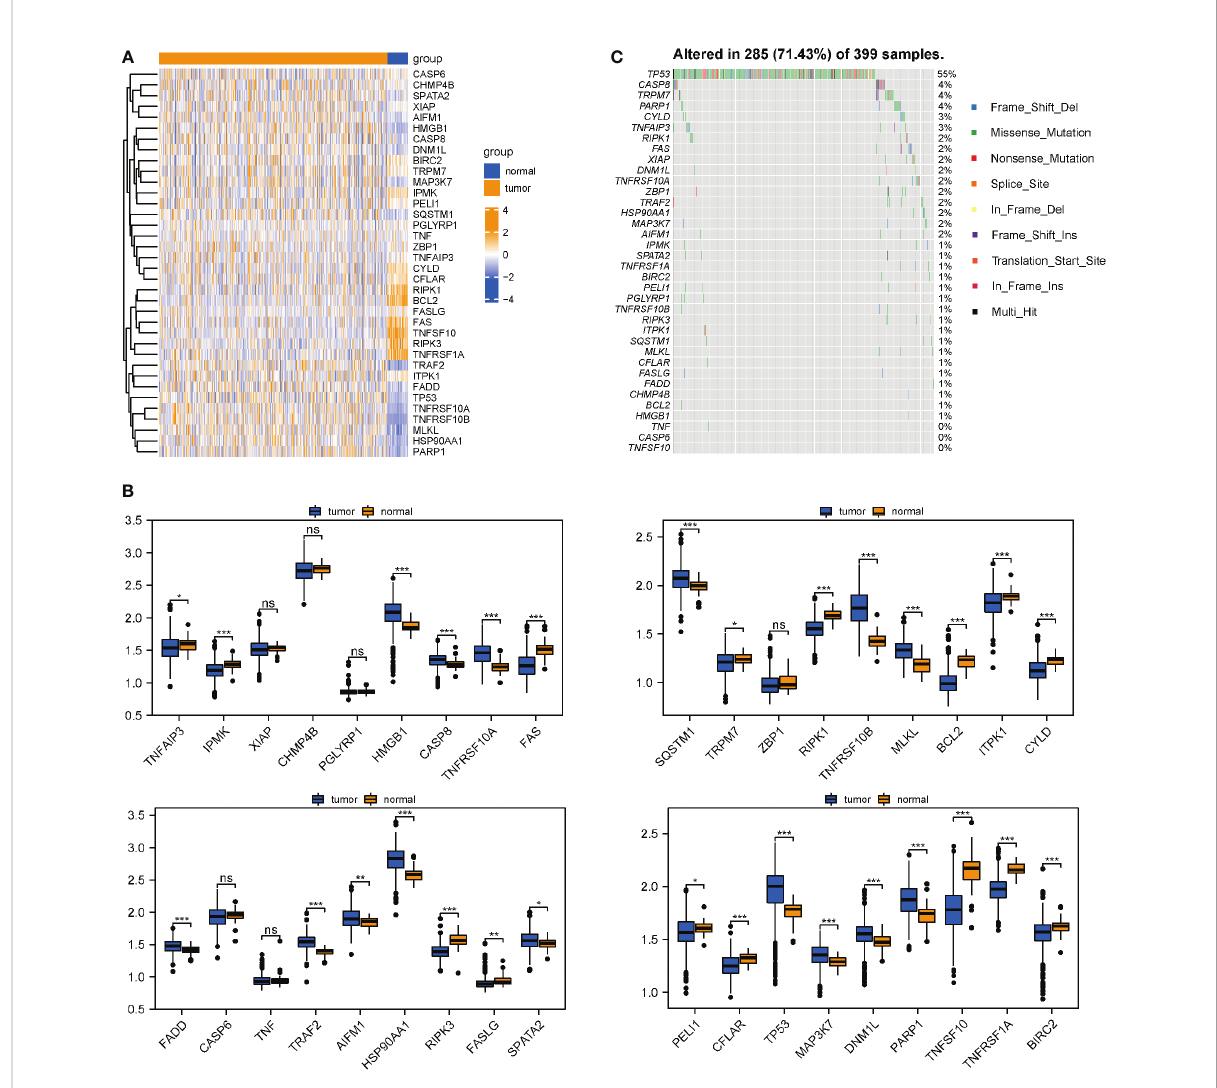
FIGURE 2 Differential expression and mutation information of necroptotic genes in TCGA-COAD datasets. (A, B) Necroptotic genes were compared between the normal and tumor groups in TCGA-COAD dataset using the Wilcoxon test. *P < 0.05, **P < 0.01, ***P < 0.001. (C) Mutation information of the necroptotic genes in TCGA-COAD. "ns" represents "no signi fi